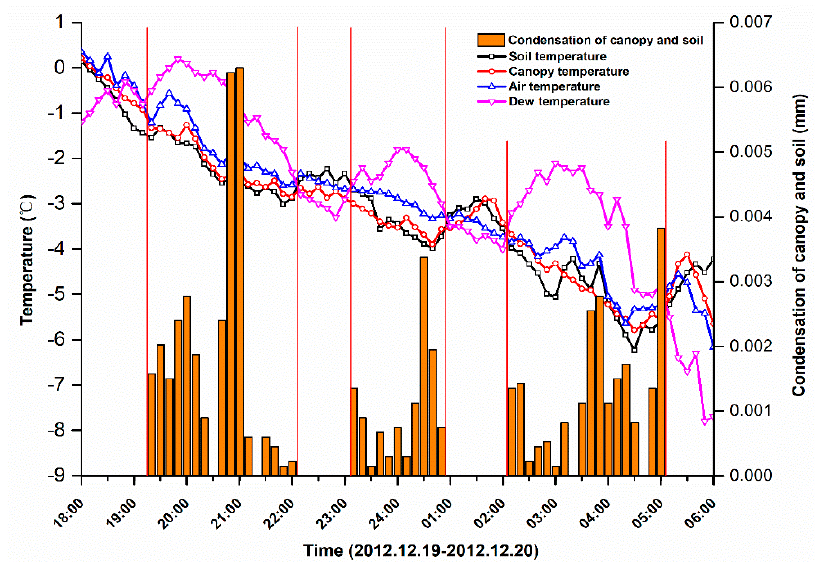
Figure 10. Changes of condensation vs different kinds of temperature on a typical night (including air, soil, canopy and dew temperature; 19–20 December 2012).